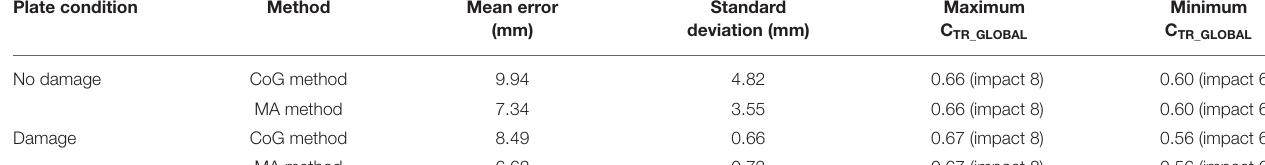
TABLE 4 | Post processing results with grid refinement.